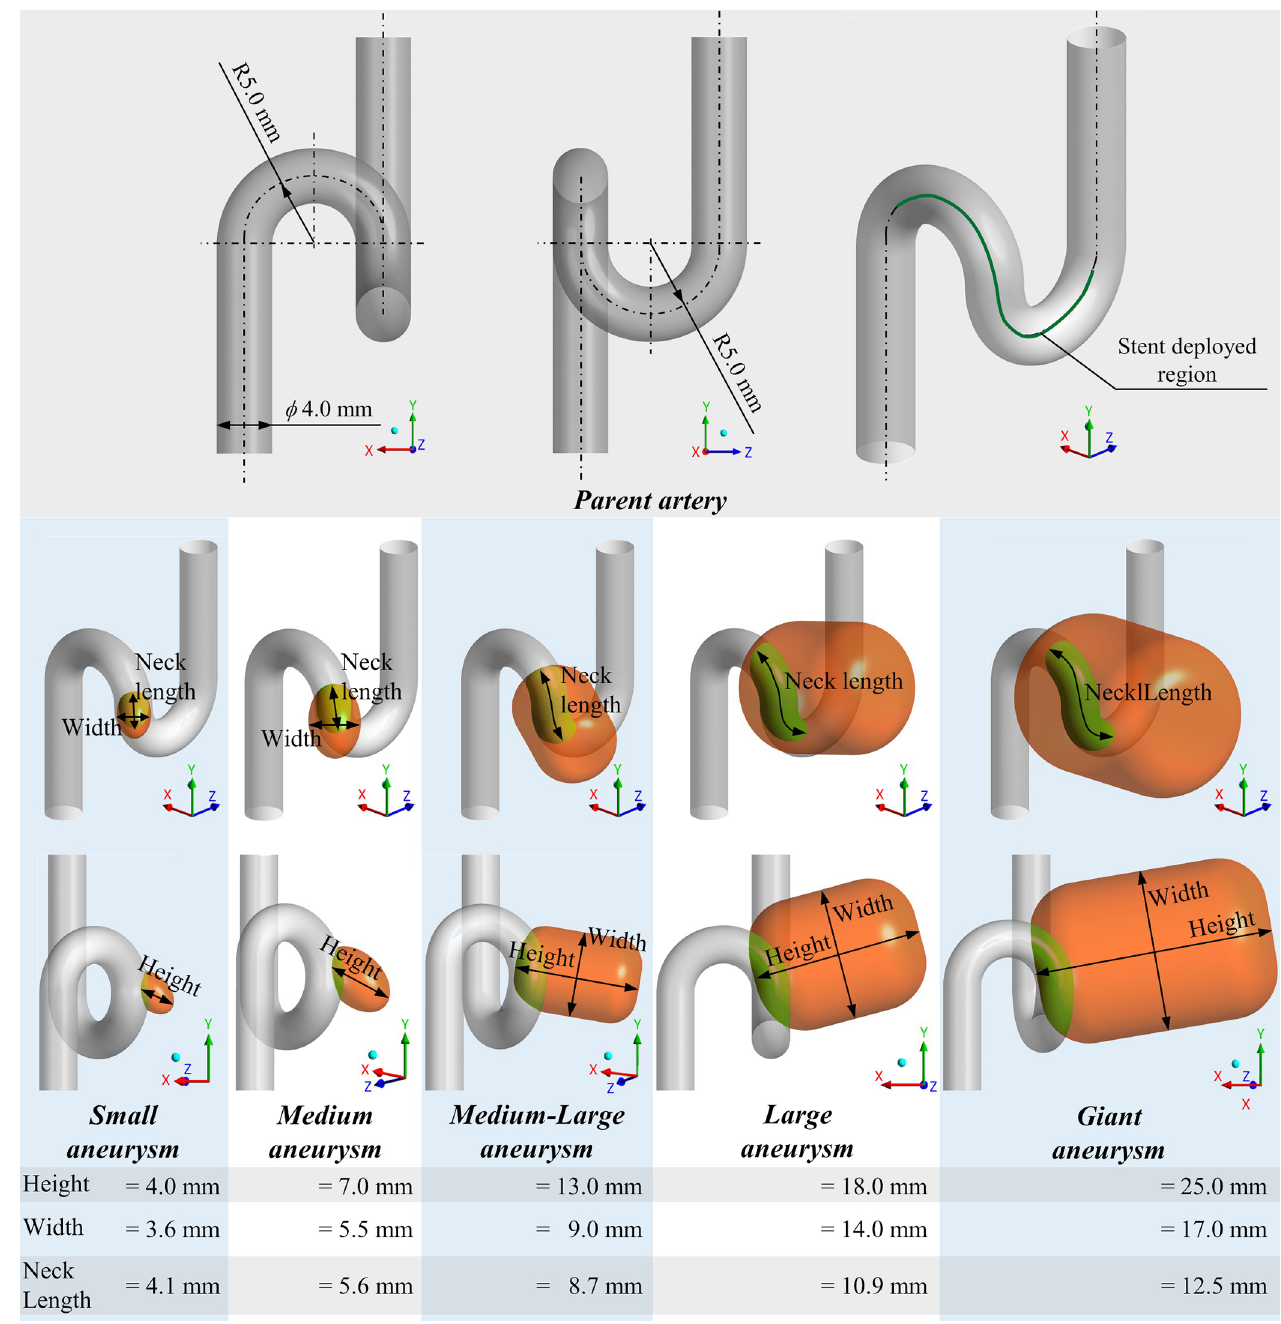
Fig 1. Generated basic aneurysm models and parent artery. The stent was deployed in the region of the green centerline. Five types of aneurysms (Small, Medium, Medium-Large, Large, and Giant) were generated by varying aneurysmal height, width, and neck length.